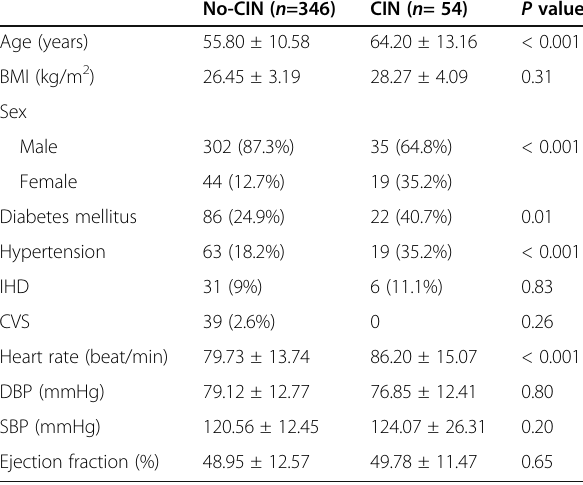
Table 1 Clinical characteristics of studied patients based on CIN development